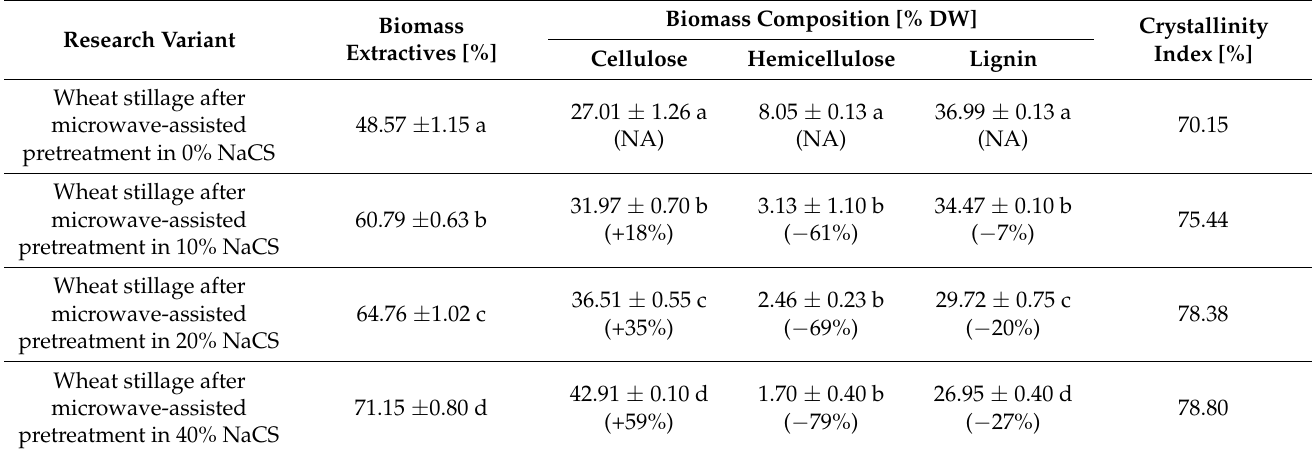
Table 1. Characteristics of wheat stillage after microwave-assisted pretreatment with